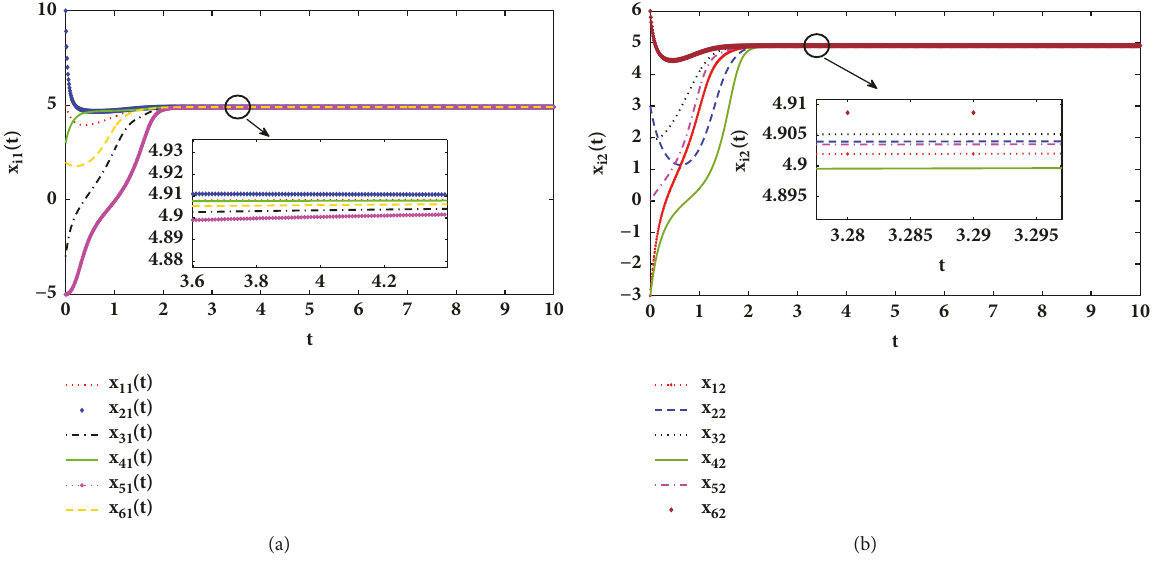
Figure 2: The states of the 𝑖 th agent (𝑖 = 1,2,3, 4,5, 6) : (a) the state 𝑥 𝑖1 along 𝑥 -axis; (b) the states 𝑥 𝑖2 along 𝑦 -axis.